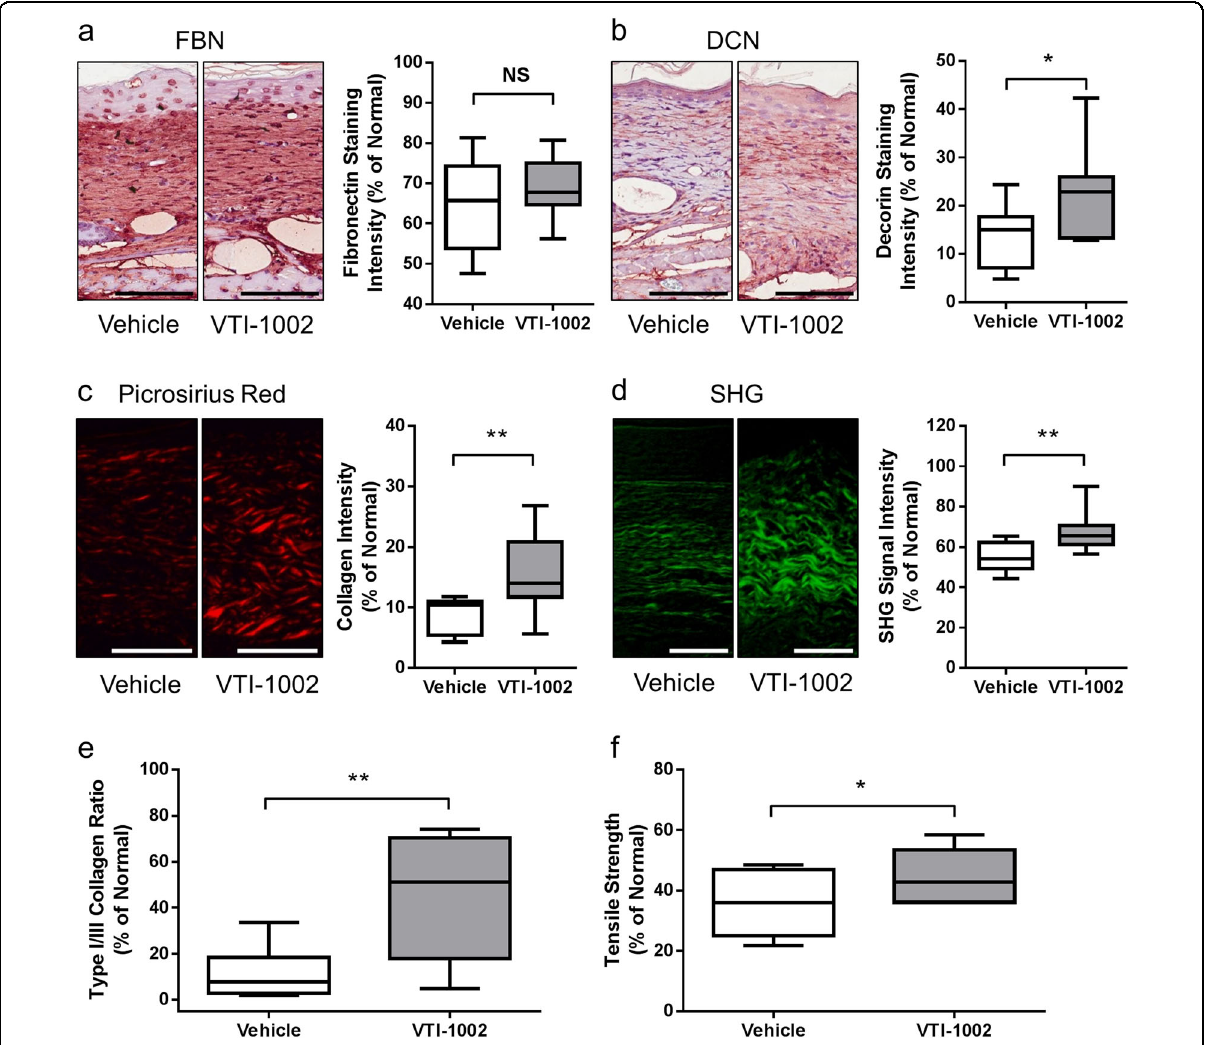
Fig. 4 Topical application of VTI-1002 gel promotes tissue remodeling in diabetic burn wounds. Representative images of a FBN ( fi bronectin), b DCN (decorin) staining, and quanti fi cation of a FBN, b DCN staining intensity in the wounds at day 30 from vehicle control group and VTI-1002 treatment group ( n ≥ 5 per group). Scale bar = 100 µm. c Representative images of Picrosirius Red staining and quanti fi cation of staining intensity in the wounds at day 30 from vehicle control group and VTI-1002 treatment group ( n ≥ 5 per group). Scale bar = 100 µm. d Representative second- harmonic generation (SHG) imaging and quanti fi cation of SHG signal intensity in the wounds at day 30 from vehicle control group and VTI-1002 treatment group ( n ≥ 5 per group). Scale bar = 50 µm. e Comparison of type I/III collagen ratio in the wounds at day 30 between vehicle control group and VTI-1002 treatment group ( n ≥ 5 per group). f Comparison of post-wound skin tensile strength at day 30 between vehicle control group and VTI-1002 treatment group ( n ≥ 5 per group). Results are expressed as median and min/max value, NS = not signi fi cant, * P < 0.05, ** P < 0.01